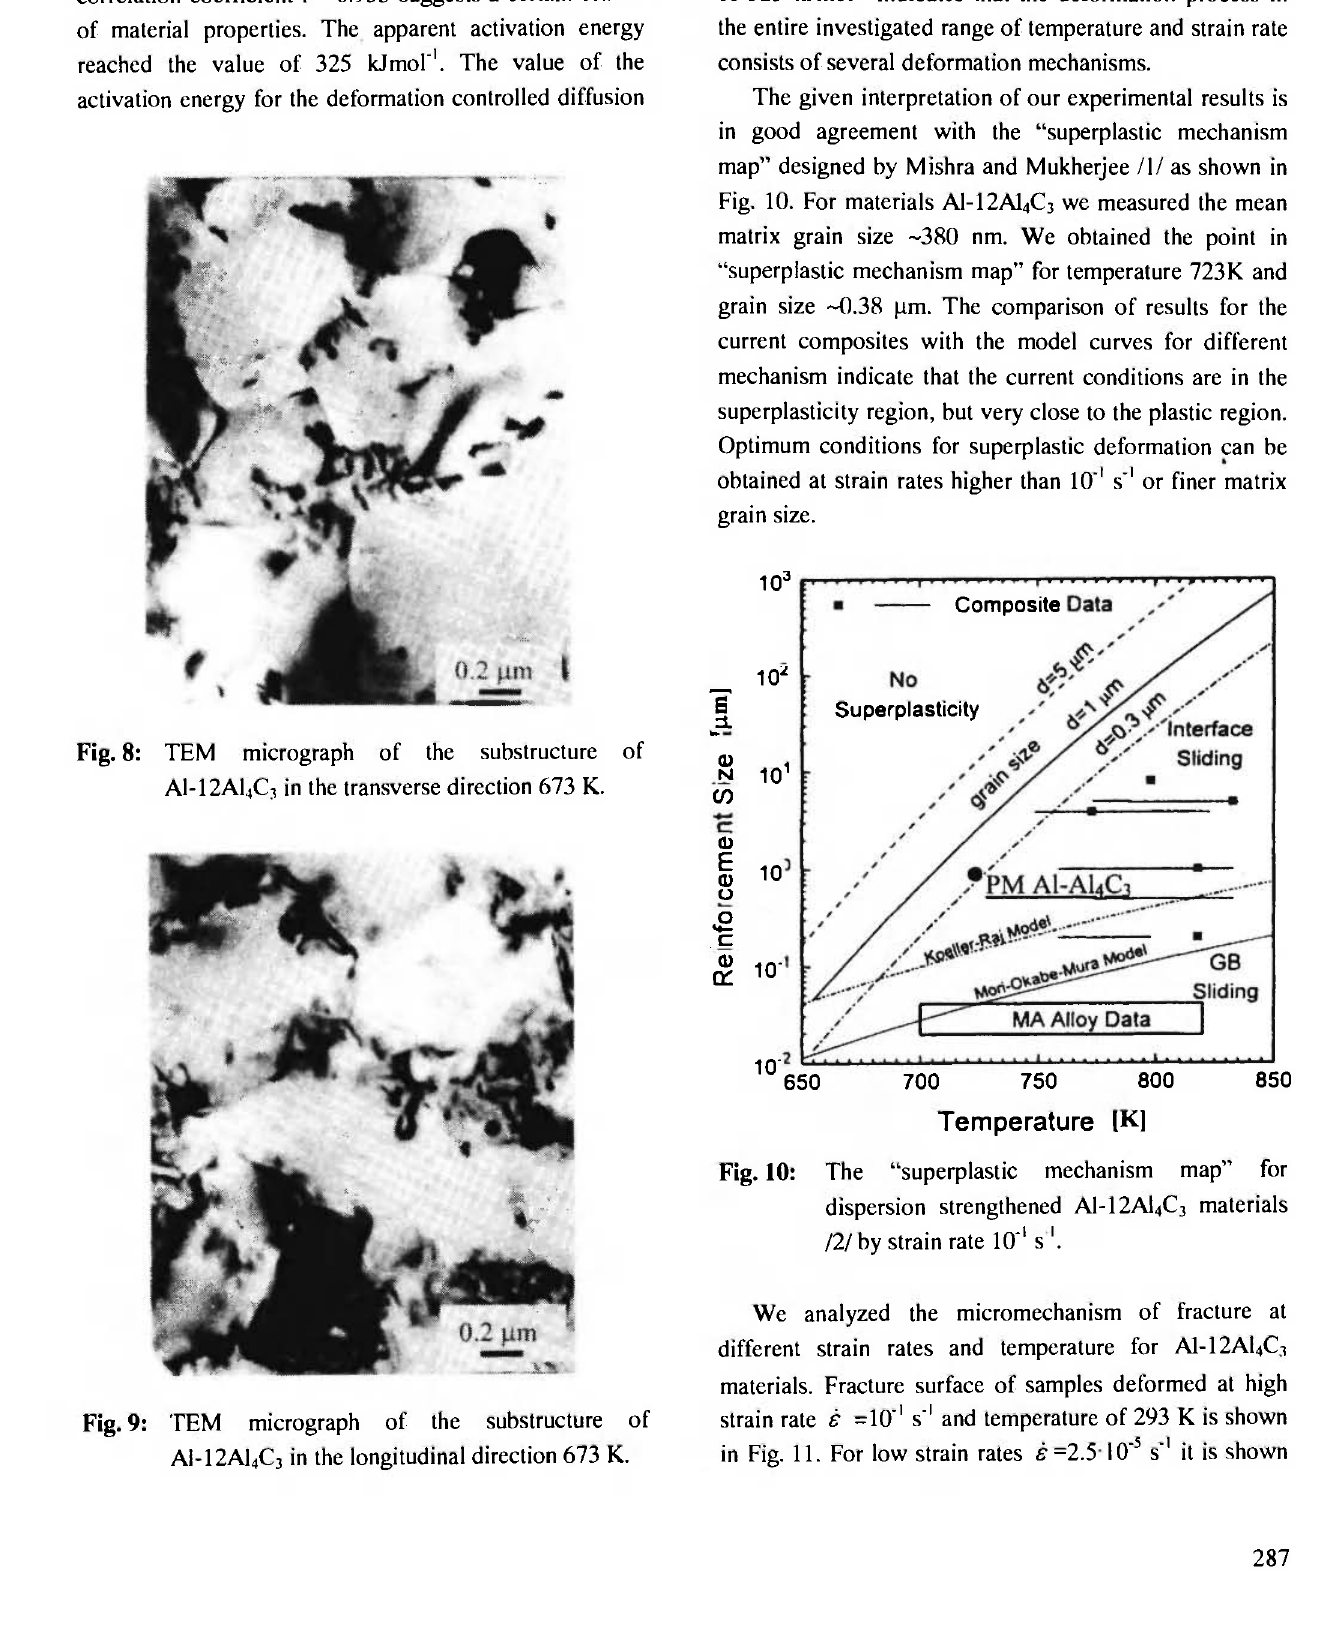
Fig. 9: ΓΕΜ micrograph of the substructure of A1-12A1 4 C 3 in the longitudinal direction 673 K.